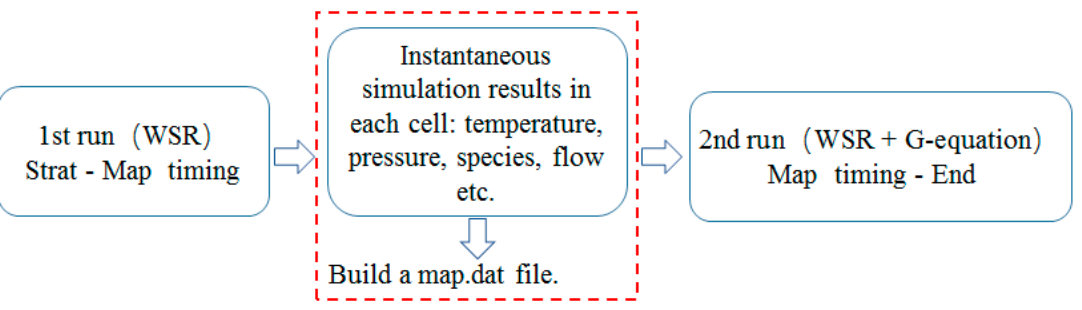
Figure 2. The flow chart of the mapping method for dual-fuel pre-chamber engine simulation.